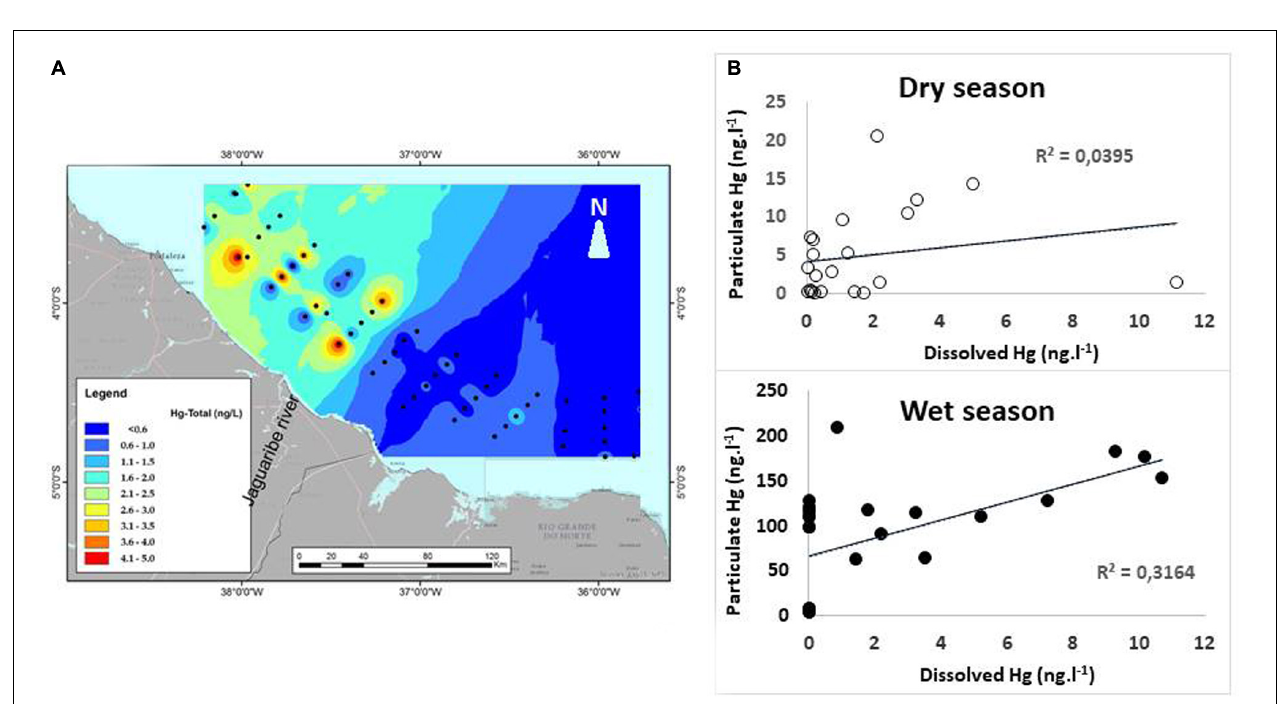
FIGURE 2 | Seasonal variation of dissolved (D-Hg) and particulate (P-Hg) Hg concentrations (A) and instantaneous fluxes (B) in the Jaguaribe River estuary, NE Brazil, based on original data in Lacerda et al. (2013).